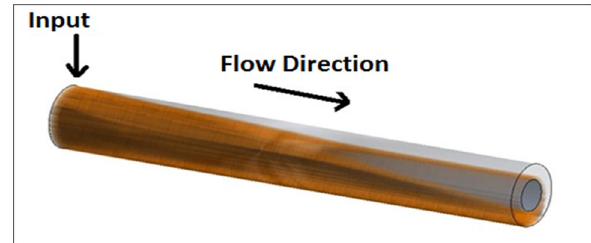
Fig. 15 3D view of cuttings distribution in the